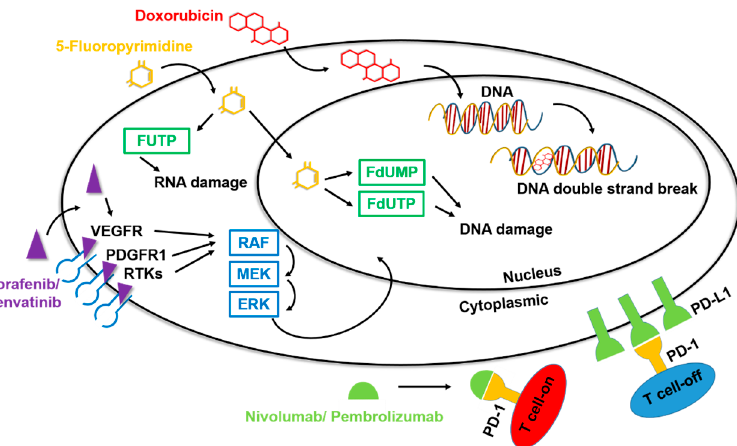
Figure 2. Mechanisms of action of drugs for HCC. Among the drugs for the clinical treatment of liver cancer, chemotherapeutic agents such as doxorubicin and 5-fluoropyrimidine can cause formation of unstable DNA in cells through the chemical structure, promoting cell apoptosis and inhibiting the carcinogenic process. The targeted drugs sorafenib and lenvatinib inhibit multiple tyrosine kinases, specifically affecting certain target RTKs such as VEGFR and PDGFR, thereby impacting downstream signal transmission. The immunotherapy drugs nivolumab and pembrolizumab have an anti-PD1 function, binding to T cells and preventing PD1 binding, thereby disrupting the inhibitory action of T cells.